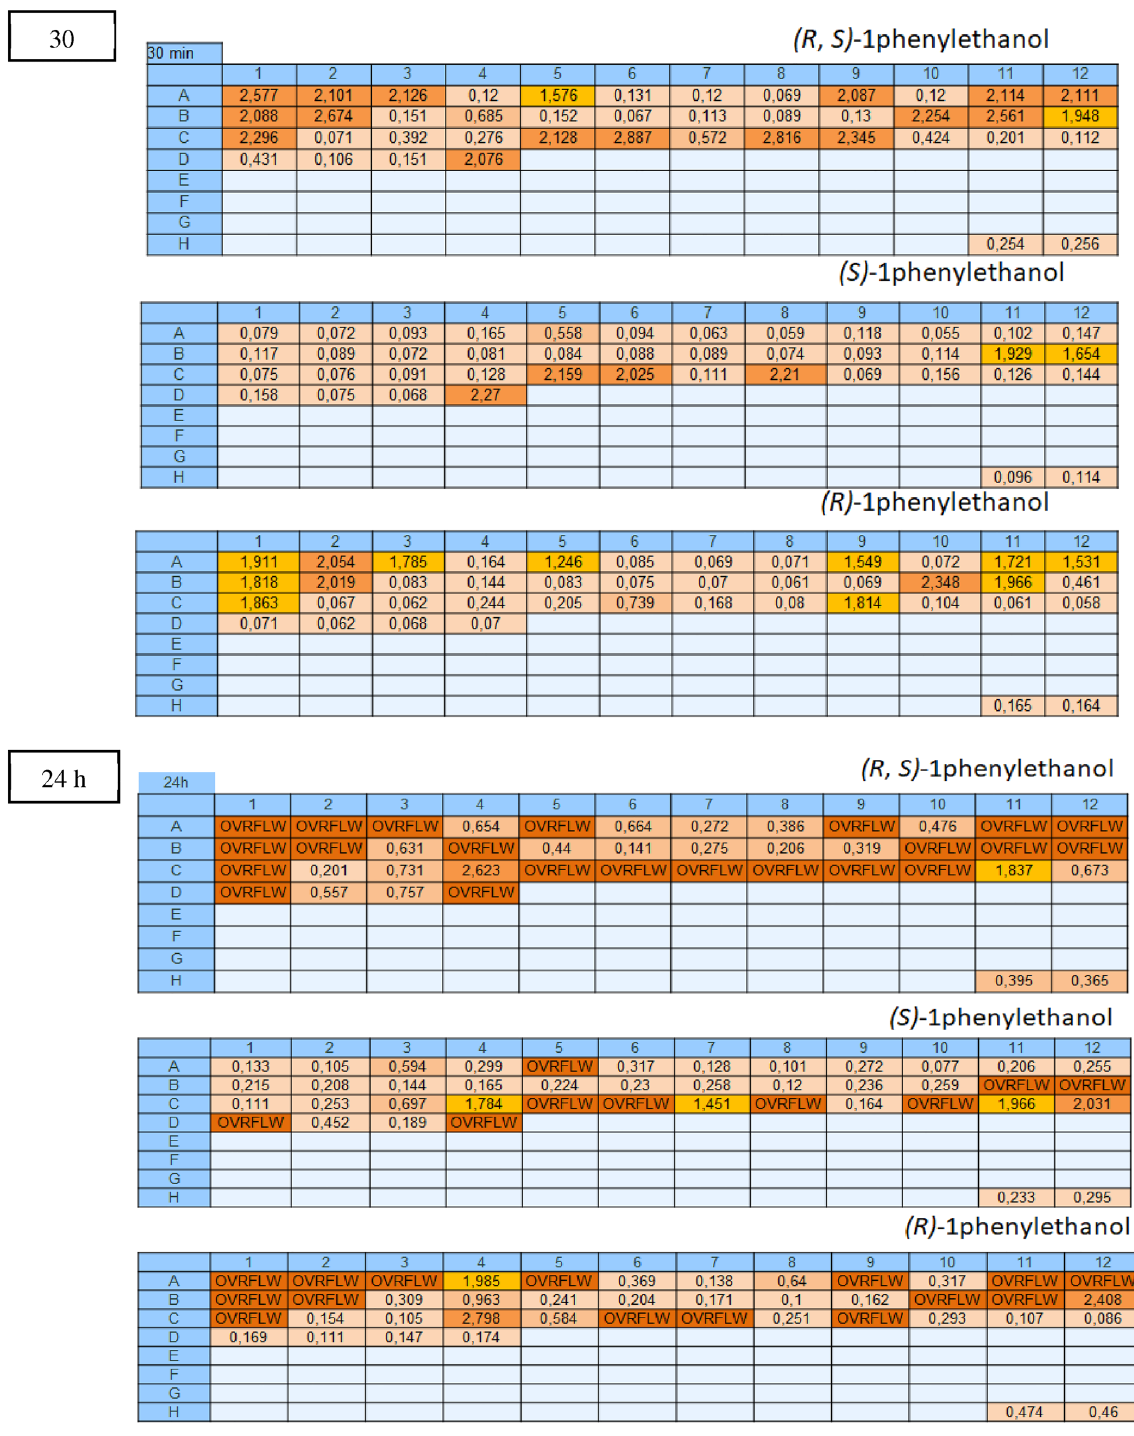
Figure 4. Comparison at 30 min and 24 h between results obtained by the addition of the racemic substrate 1 and the pure enantiomers ( (R) - 1 and (S) - 1 ). Increased orange color intensity corresponds to higher absorbance values (reported in the cells) and consequently to a more active enzyme. Ovrflw: absorbance values over 3 (corresponding to the limit of the instrument used for the